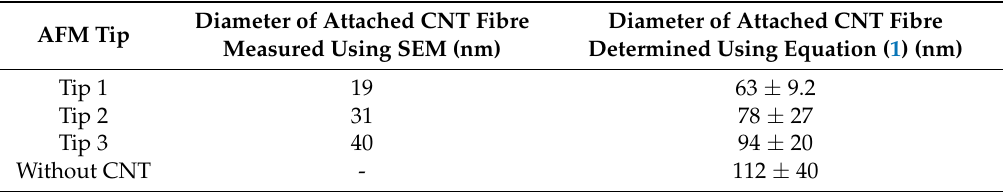
Table 1. A comparison of the measured diameter of the attached CNT fibres to tips 1–3 from Figure 1 using SEM analysis and Equation (1) which relies on AFM